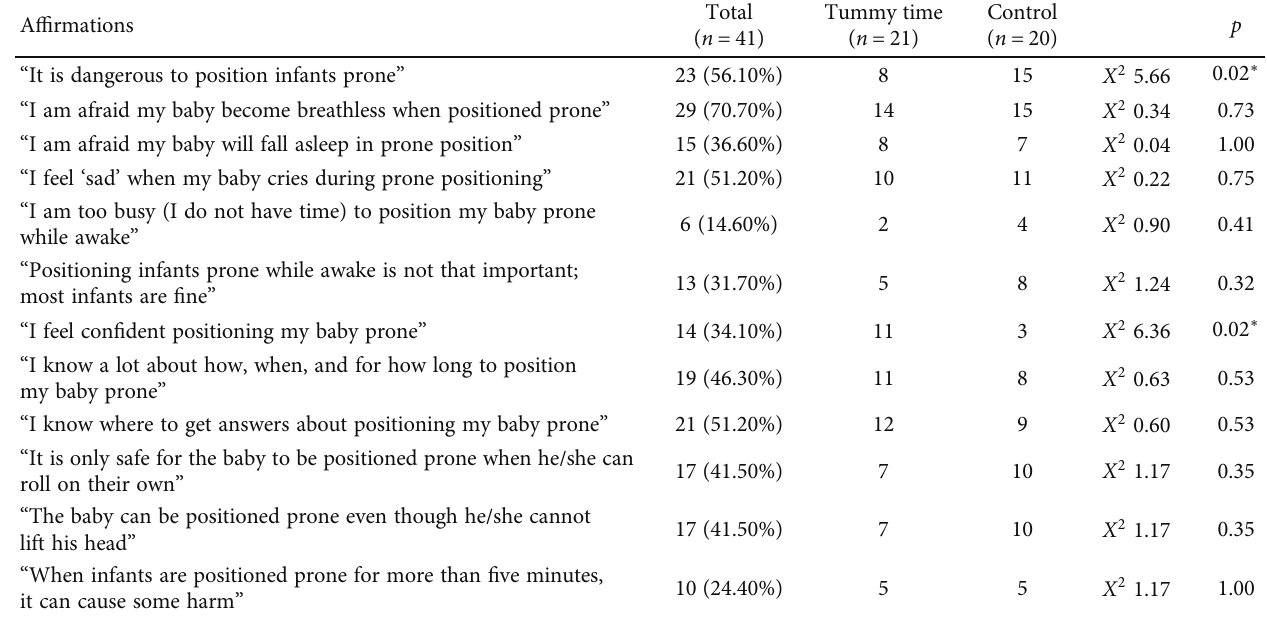
Table 2: Factors related to decision-making on tummy time practice in the fi rst interview.